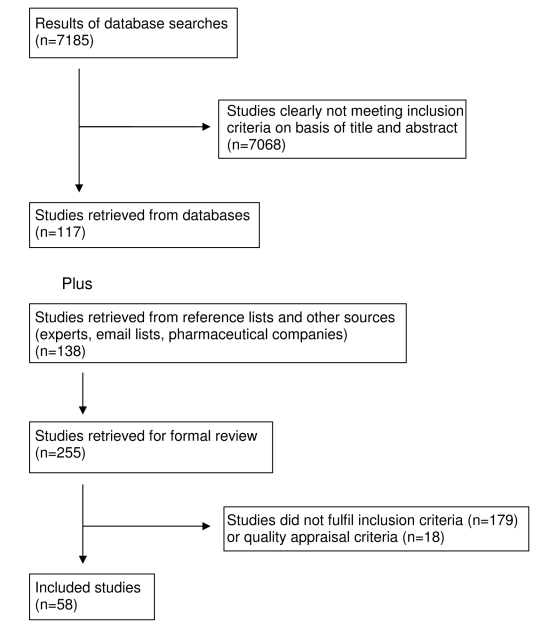
Study flow diagram.